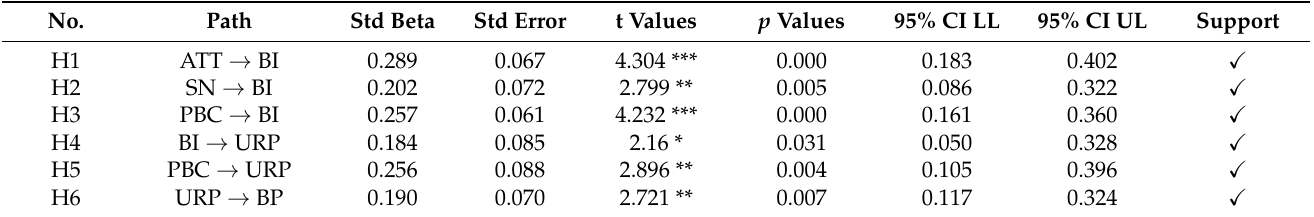
Table 4. Hypotheses